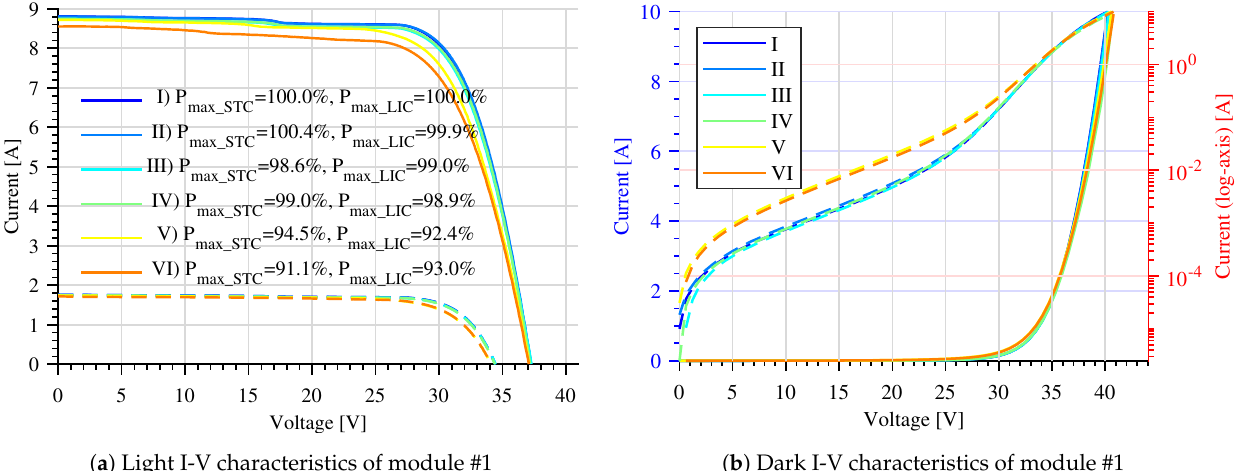
Figure 3. Electrical characteristics and relative maximum power loss of module #1 measured during the accelerated stress test: ( a ) light I-V characteristics measured at STC and low irradiance conditions (LIC, 200 W/m 2 ); ( b ) dark I-V characteristics of module #1 measured at 25